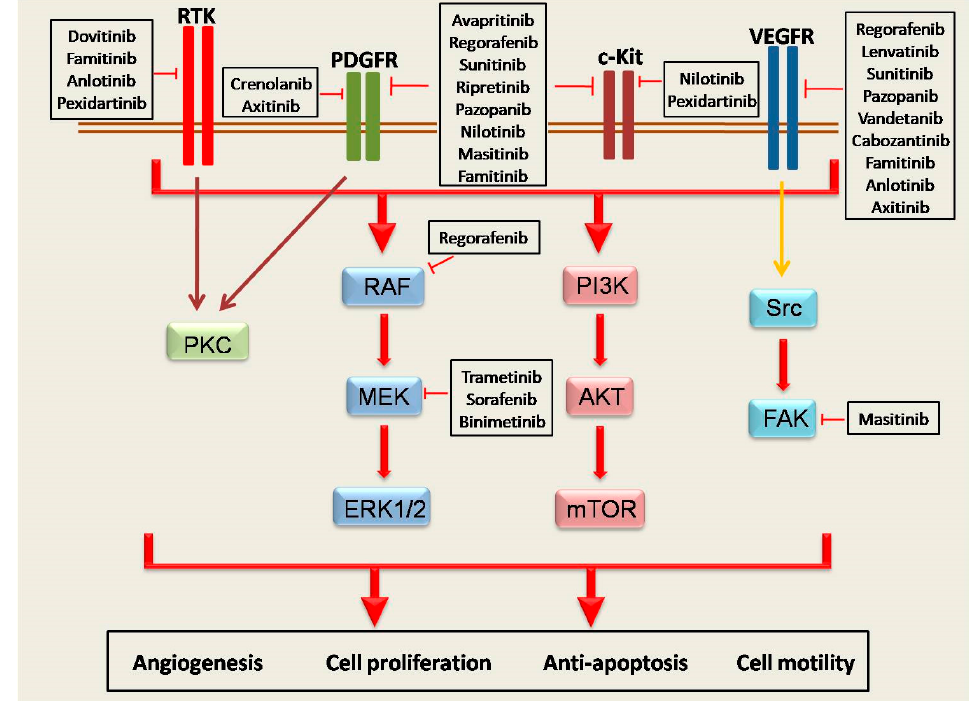
Figure 1. The role of the receptors in the activation of signaling pathways in GISTs. The four major receptors groups (RTKs, PDGFR, c-KIT, and VEGFR) closely regulate the cellular process such as angiogenesis, cell proliferation and motility, and anti-apoptotic capability of cancer cells through the induction of RAF/MEK/ERK, PI3K/AKT/mTOR, PKC, and Src/FAK axis. In addition, a plethora of small agents that directly target the receptors or signaling pathways is presented in the